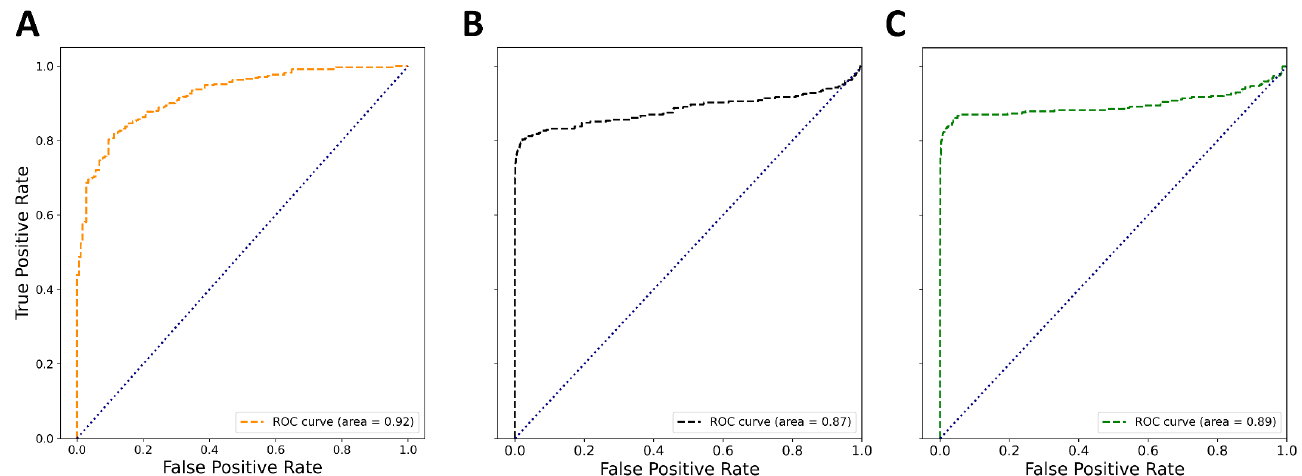
Figure 5. ROC curves obtained for the top-performing RF:ECFP4 binary model. ( A ) Results of external validation; ( B ) results of external validation on the decoy dataset; ( C ) results of external validation on the decoy dataset after applicability-domain corrections.